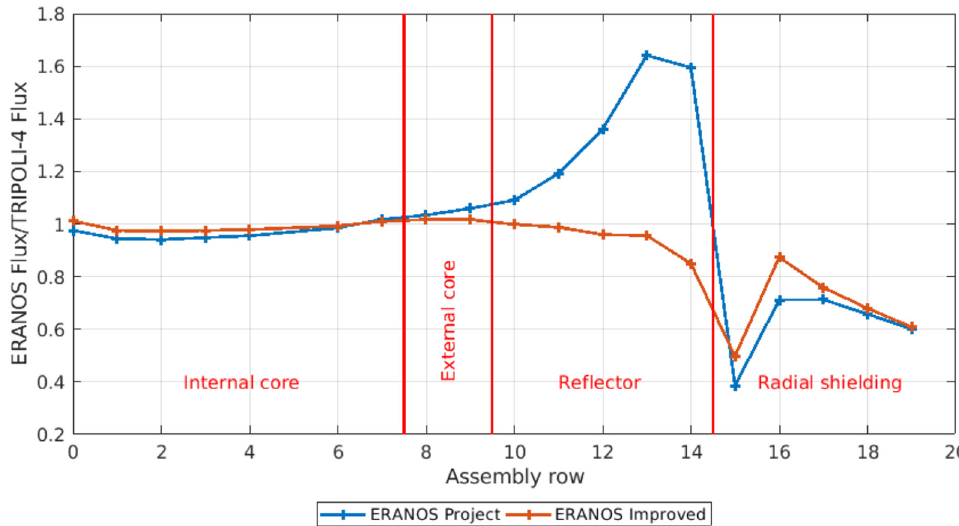
Fig. 13. Comparison between the ERANOS and the TRIPOLI-4 ® codes on the radial traverse of the ASTRID core.